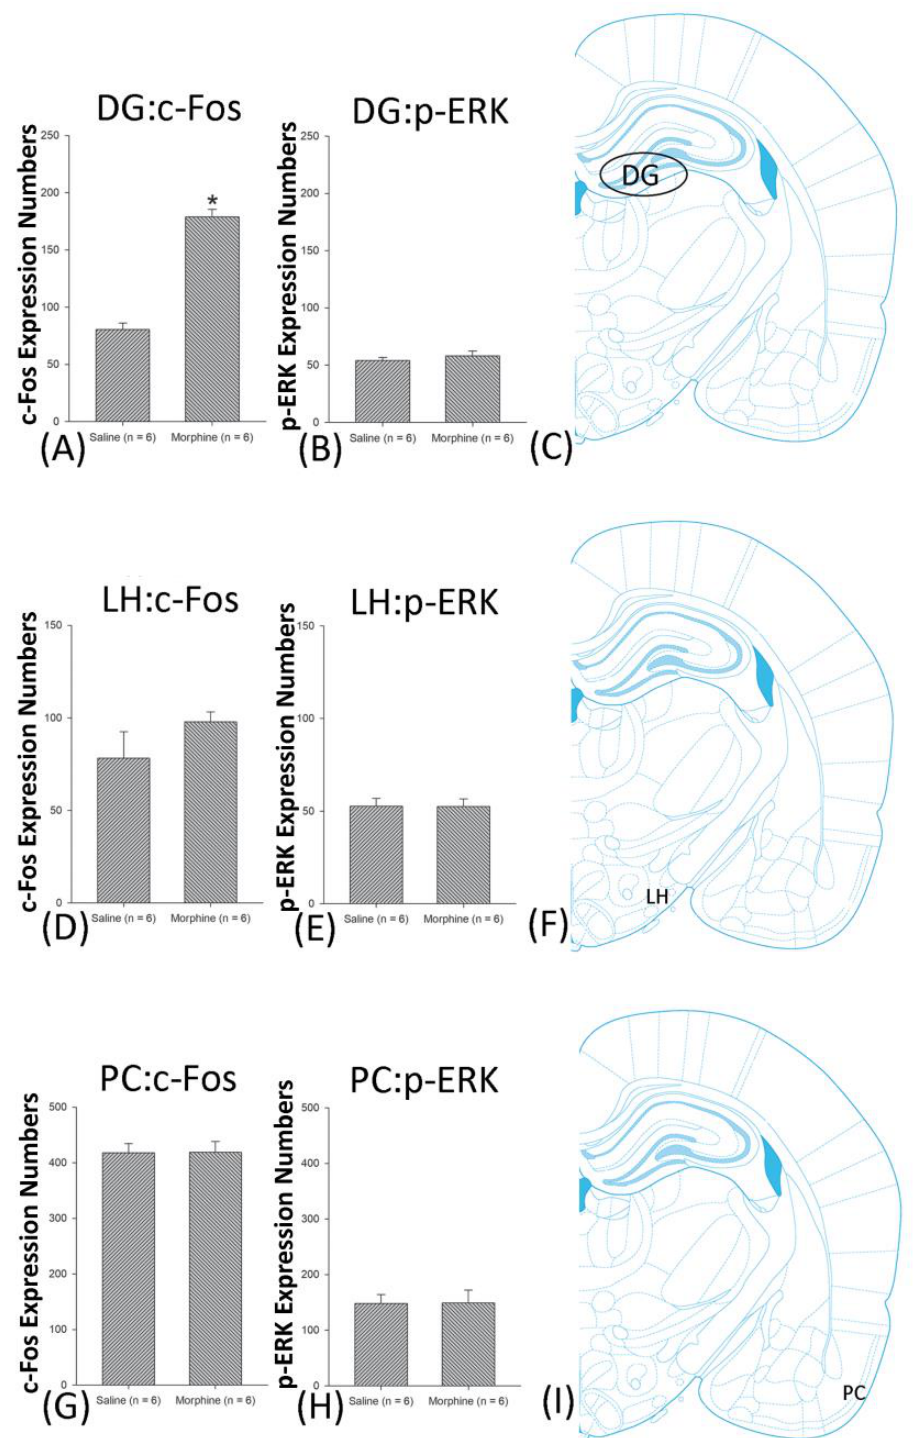
Figure 9. c-Fos or p-ERK expression in the dentate gyrus (DG), lateral hypothalamus (LH), and piriform cortex (PC) in conditioning. ( A , B ) c-Fos expression and p-ERK expression in the DG, ( D , E ) in the LH, and ( G , H ) in PC for conditioning. ( C , F , I ) show a schematic representation of the DG, LH, and PC. * p < 0.05 when comparing the saline and morphine groups ( n = 6 per group).